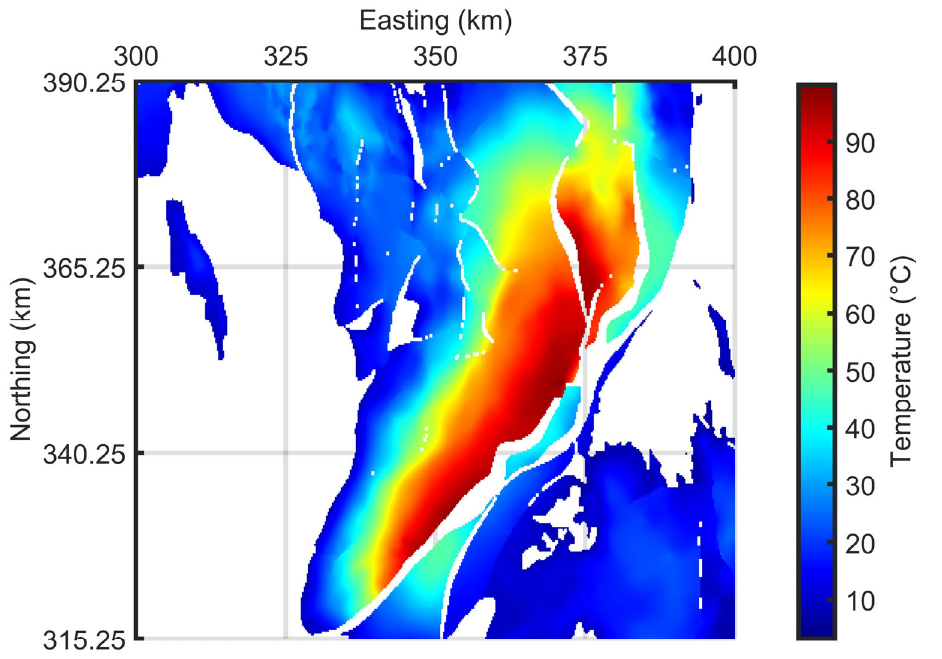
Figure 7. Temperature map of the Cheshire Basin using 20 °C/km geothermal gradient. Resolution of 250 m spacing. Derived from South West Pennines Model, Lithoframe 3D model—250K data, 13,160 km 2 scale BGS Digital Data under License 2022/067-V2 British Geological Survey © and Database Right UKRI. All rights reserved [58].